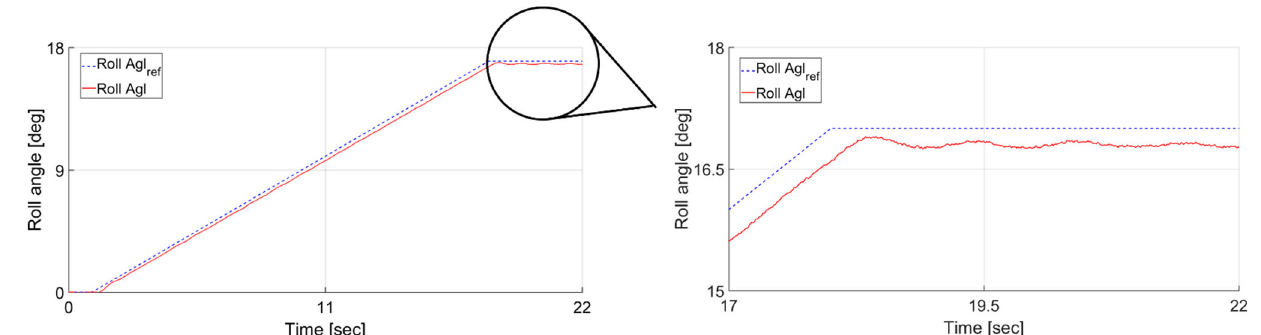
Figure 8. Roll direction bending response.